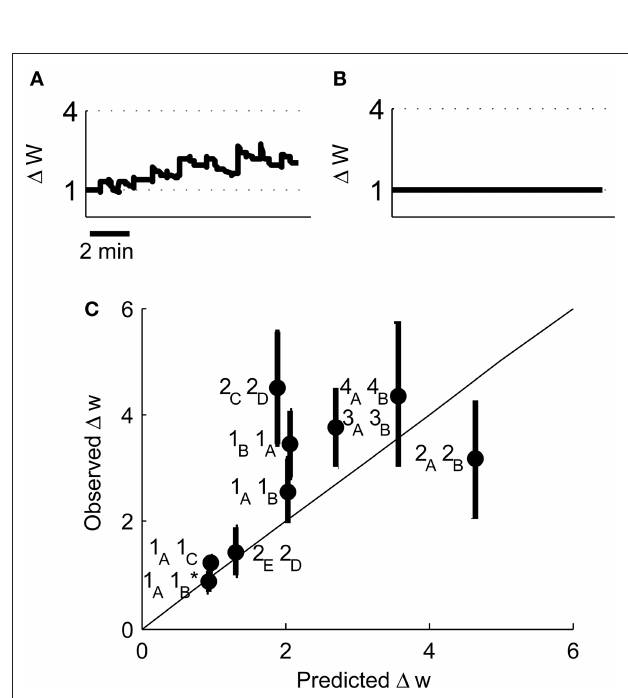
Figure 10 | Predicted synaptic weight changes for place cell activity with specific spike patterns. Calculated synaptic weight changes for a pair of overlapping place cells with an asymmetric cross-correlation 1 of place cells where all spike intervals with positive ∆ t less than 100 ms have been removed 1 , 1 (B) . (C) A comparison between the induced plasticity A B predicted by the model and the observed plasticity from experimental data (Isaac et al.,